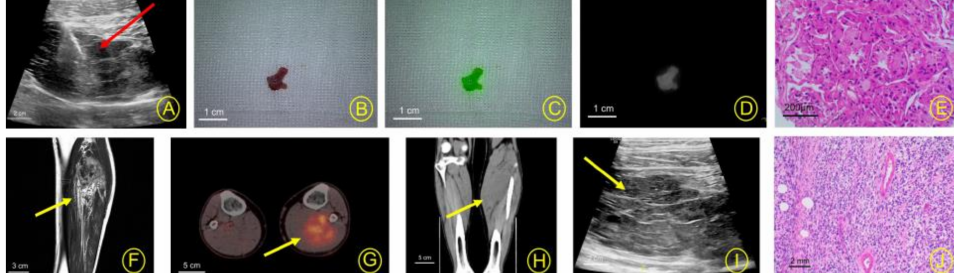
Figure 3. Thirty-two-year-old male suspected to have malignant tumors of the lower limb soft tissue. ( A ) Under the guidance of B-ultrasound, the biopsy needle was implanted into the lesion (red arrow). ( B – D ) The naked-eye view of the biopsy lesions, the green fluorescence, and original fluorescence of the real-time fluorescence development of the biopsy lesions. ( E ) The histopathologic biopsy results (hematoxylin and eosin, original magnification 100 × ) confirmed the bone lesion as a non- Hodgkin’s lymphoma. ( F – I ) Medical imaging before biopsy for the diagnosis of soft tissue tumors (yellow arrow). ( J ) The pathological results (non-Hodgkin’s lymphoma) after surgical resection of the humeral tumor were consistent with the pathological results of the biopsy (hematoxylin and eosin, original magnification 40 ×